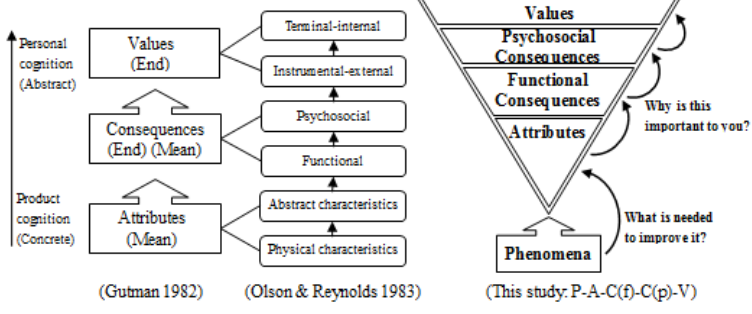
Figure 2. Comparison between Means-End Chain Model and this study Laddering is simply a technique for collecting Means-End Chains from